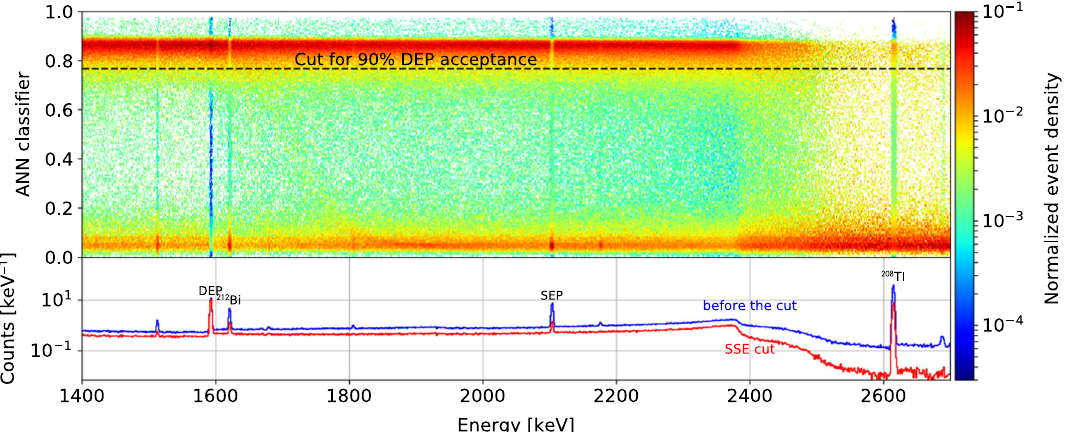
Fig. 20 2D histogram showing the classified 228 Th events (measured data) with ANN trained on the MC data. The bottom panel shows the corresponding energy spectra (before/after cut). SSEs and MSEs are